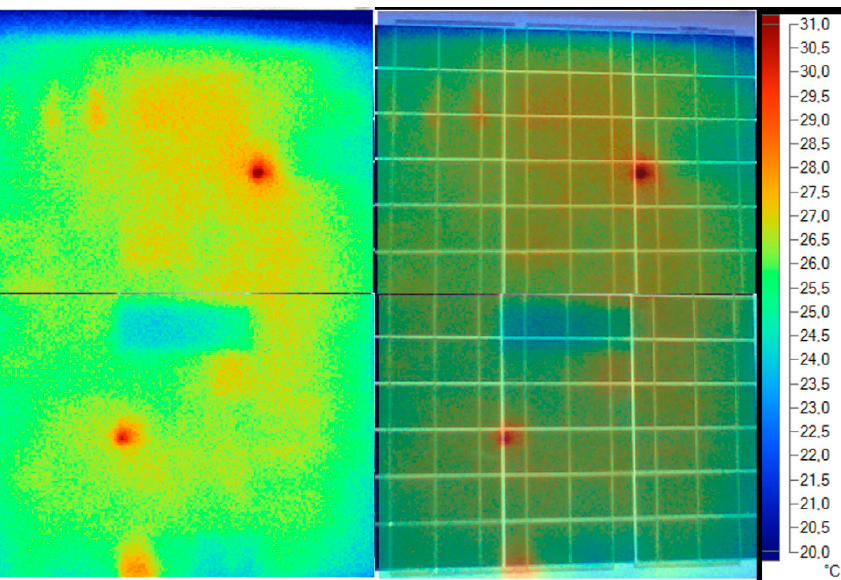
Figure 15. Thermal images of the panel applying a 22.4 V voltage. Images on the left show only IR; the ones on the right show 50% IR and 50% VIS.